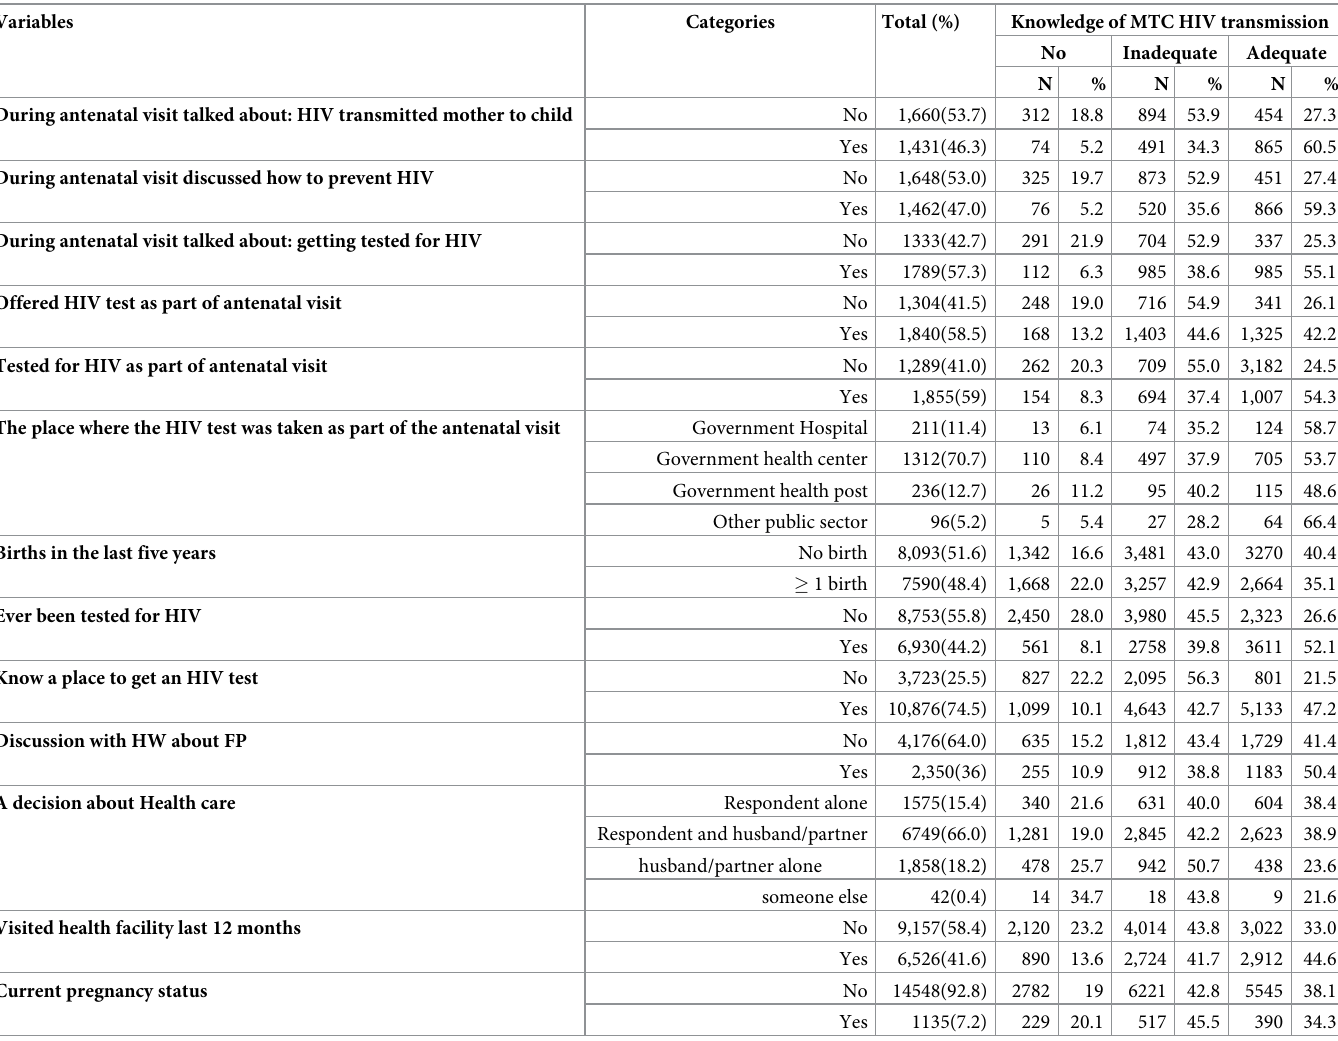
Table 2. Antenatal care-related and individual characteristics of reproductive-age women in Ethiopia, EDHS 2016.